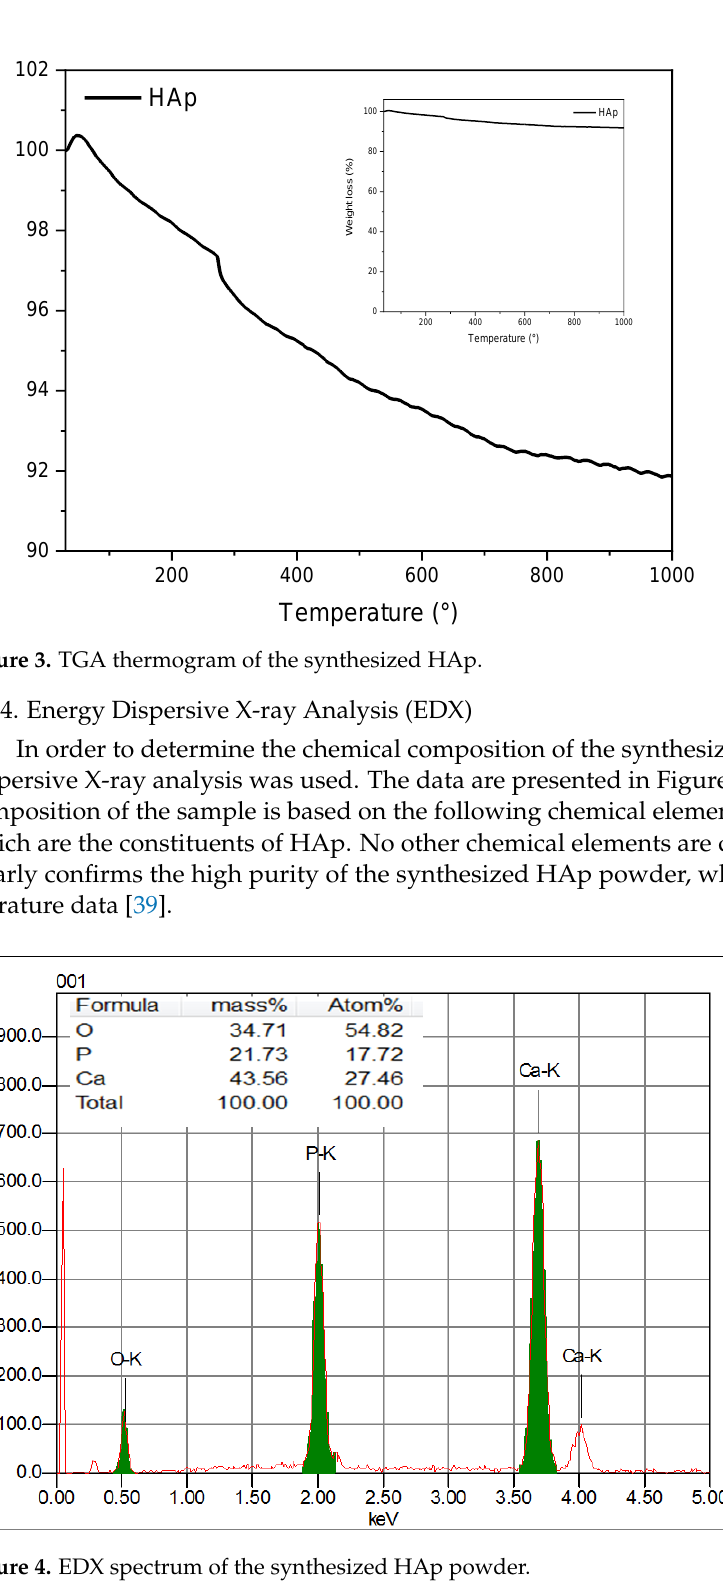
( b) Figure 5. SEM micrographs of the synthesized HAp at ( a ): ×2000 and ( b ): ×1000.